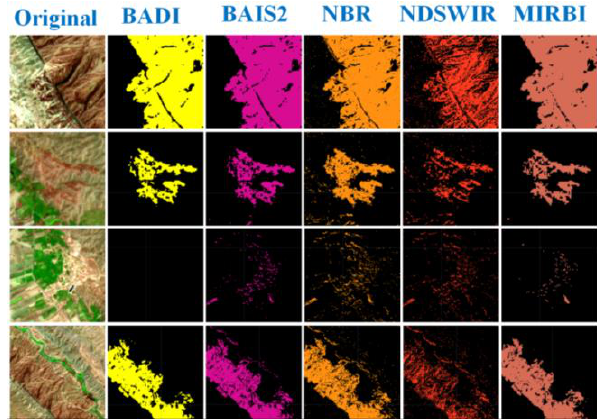
Figure 7. Portions of the original image (B12, B8, B4) and their local-scale binary maps in the study area. Columns 2-5 show the different binary maps extracted from the spectral indices.